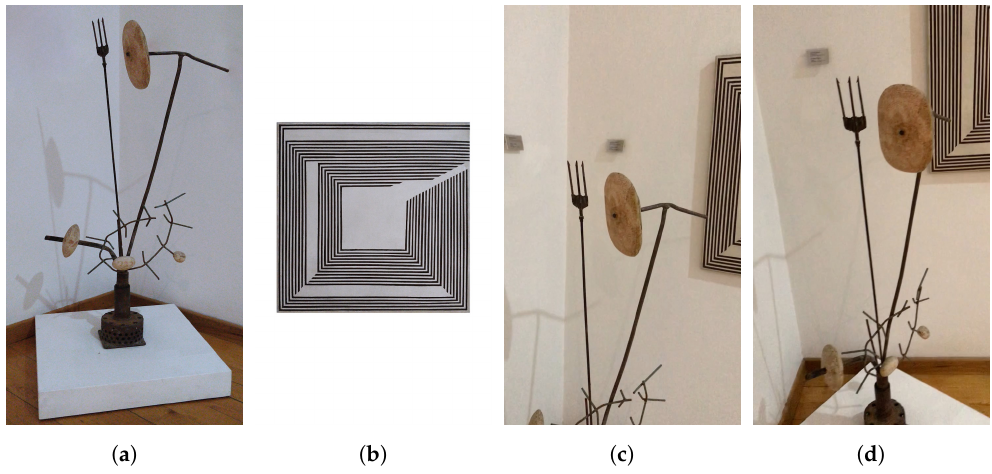
Figure 9. Misclassifications between artworks 5 and 7: ( a ) artwork 5; ( b ) artwork 7; ( c , d ) taking a photo of artwork 5 under certain angles of view. Table 4. Prediction accuracy (%) for all brightness variations and visitor occlusions at 50%